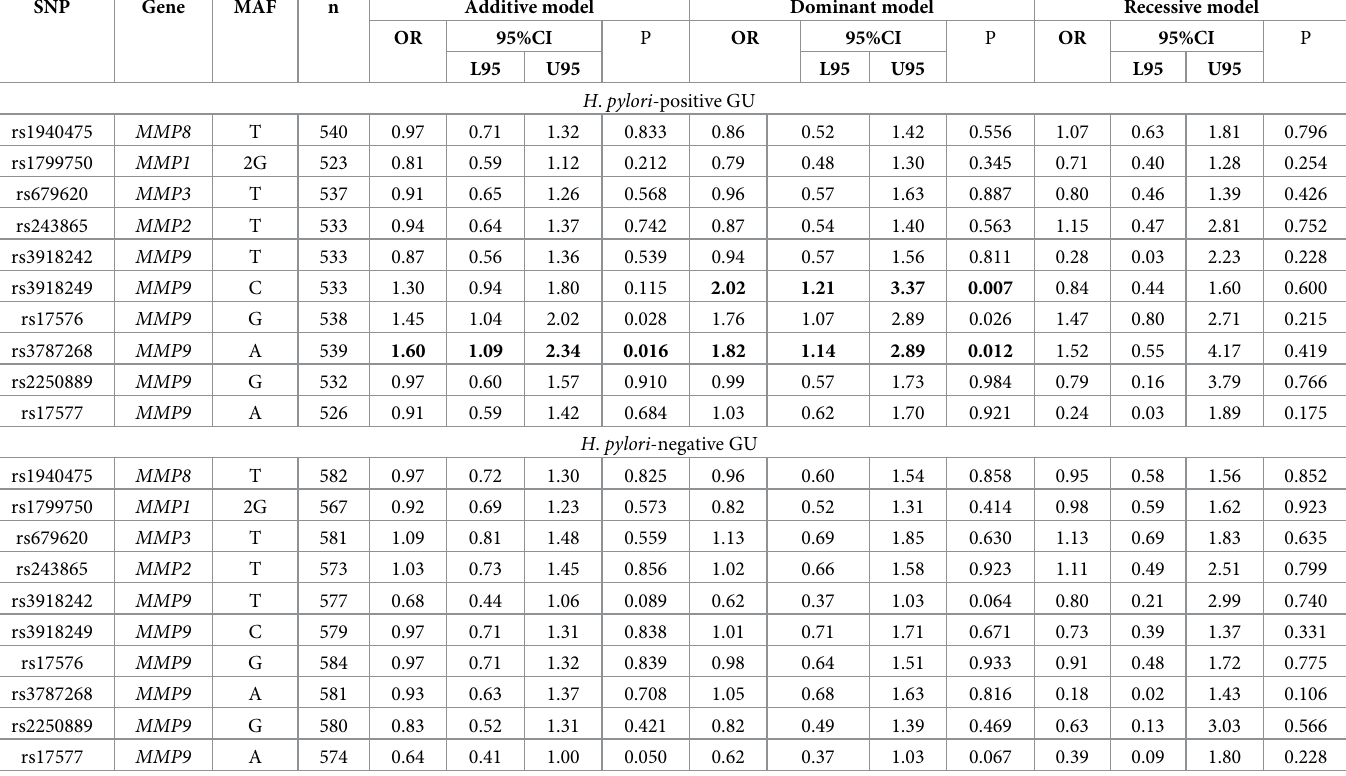
Table 3. Associations of the MMP gene polymorphisms with H . pylori -positive and H . pylori -negative GU.